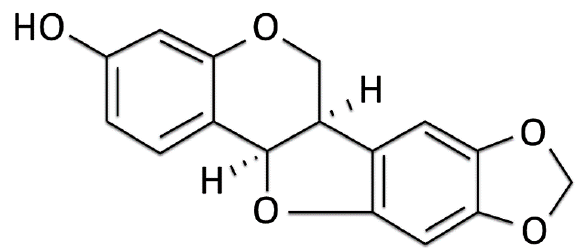
Figure 1. Chemical structure of maackiain.